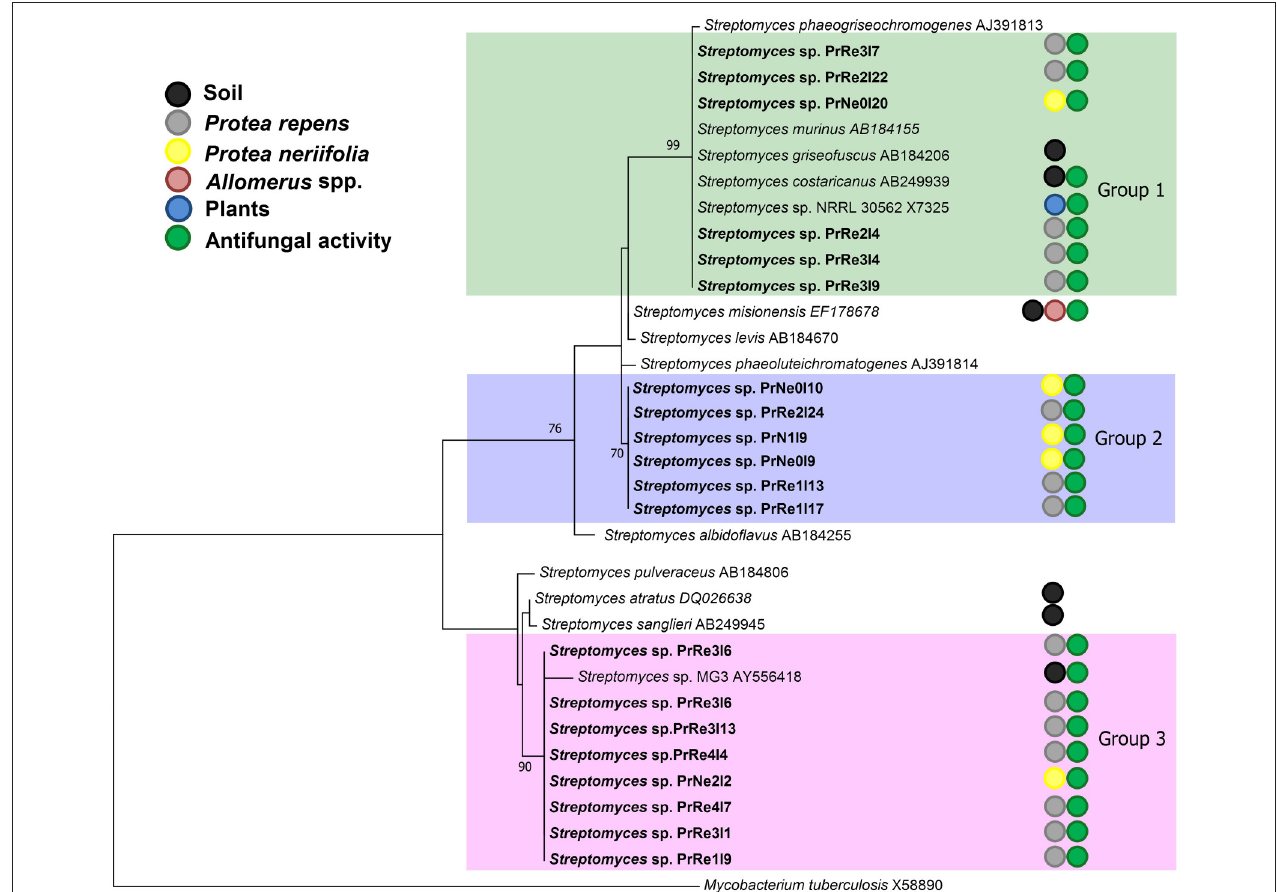
FIGURE 2 | A ML tree exhibiting the phylogenetic relationships based on 16S rRNA gene sequence of Streptomyces species obtained during the present study. Isolate numbers from this study are printed in bold type. Groups of isolates are indicated by shaded areas.